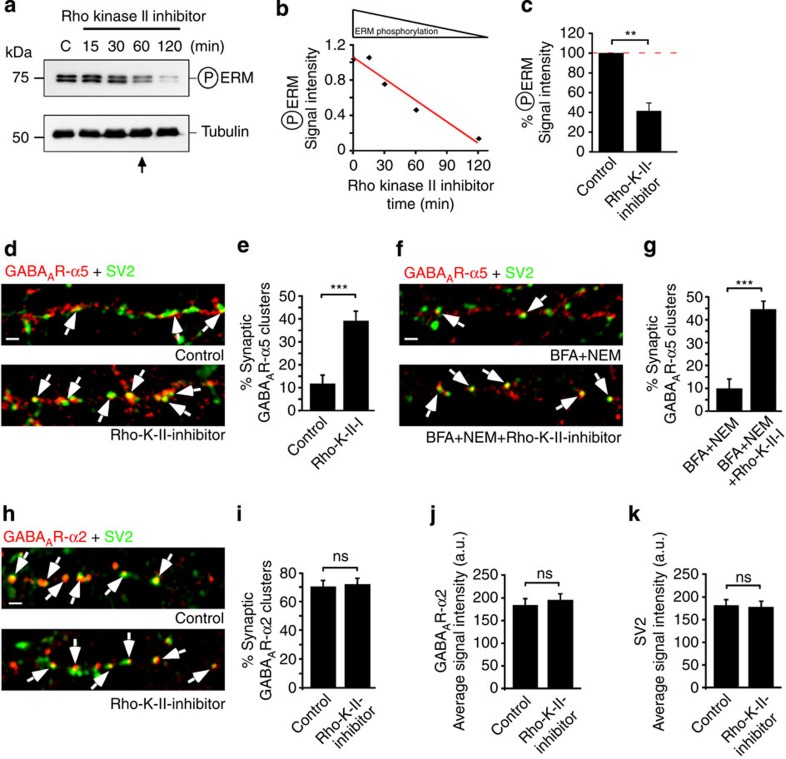
Rho kinase inhibition decreases PERM levels and increases GABAAR-α5 synaptic concentration.(a,b) Rho kinase II inhibitor decreases phosphorylated ezrin/radixin/moesin (PERM) levels in hippocampal neurons over time. (c) Quantification of PERM levels on Rho kinase II inhibitor treatment for 1 h (control: 100%, Rho-K-II-inhibitor: 40.30±7.80%; graph corresponds to 60 min values shown in a (black arrow); n=4). (d–g) Synaptic localization of GABAAR-α5 in neuronal dendrites (white arrows) treated with Rho kinase II inhibitor in the (d) absence and (f) presence of BFA and NEM for 1 h. Quantification of n=3 experiments with 12–20 cells each. Note: decreased phosphorylation of Rdx through Rho kinase II inhibitor increases synaptic GABAAR-α5 levels (see e; control: 11.59±3.71%, Rho-K-II-inhibitor: 38.90±4.04%) also in the presence of BFA and NEM (see g; BFA+NEM: 9.82±4.04%, BFA+NEM+Rho-K-II-inhibitor: 44.27±3.71%). (h,i) Synaptic localization of GABAAR-α2 (control: 70.69±3.90%, Rho-K-II-inhibitor: 71.55±3.90%) and signal intensities for (j) GABAAR-α2 (control: 181.03±13.23%, Rho-K-II-inhibitor: 192.02±13.23%) and (k) SV2 (control: 178.43±11.14%, Rho-K-II-inhibitor: 174.86±11.14%) remain unchanged after Rho-K-II-inhibitor treatment indicating no increase in synapse density. Error bars, mean±s.e.m. Scale bars, 3 μm. The Student's t-test and ANOVA were used for statistical analysis (***P<0.001; **P<0.01). NS, not significant.